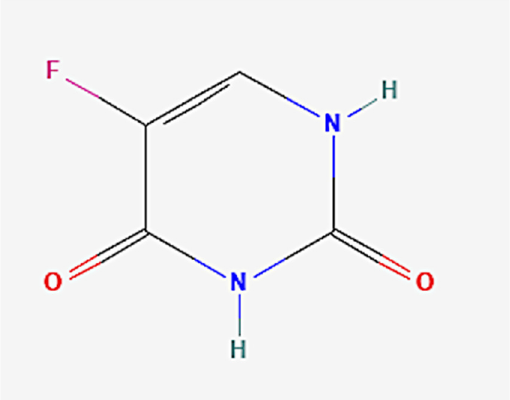
Figure 1. Chemical structure of 5-FU. https://pubchem.ncbi.nlm.nih.gov/compound/5-Fluorouracil (accessed on 28 January 2022).